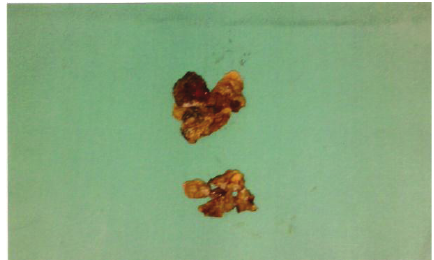
Figure 4: Rhinolith removed in two